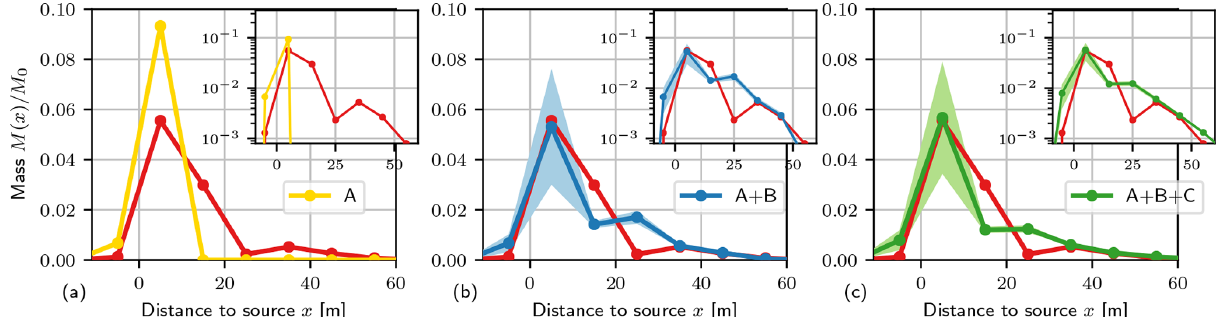
Figure 6. Longitudinal mass distribution at T = 126 days for conductivity concepts: (A) deterministic zones (a) , (A+B) inclusions in zones (b) , and (A+B+C) inclusion in zones with subscale heterogeneity (c) (Fig. 5). Shaded areas (light blue and green) indicate parametric uncertainty bands. Mass distribution observed at MADE experiment in red; the semi-log scale is in the